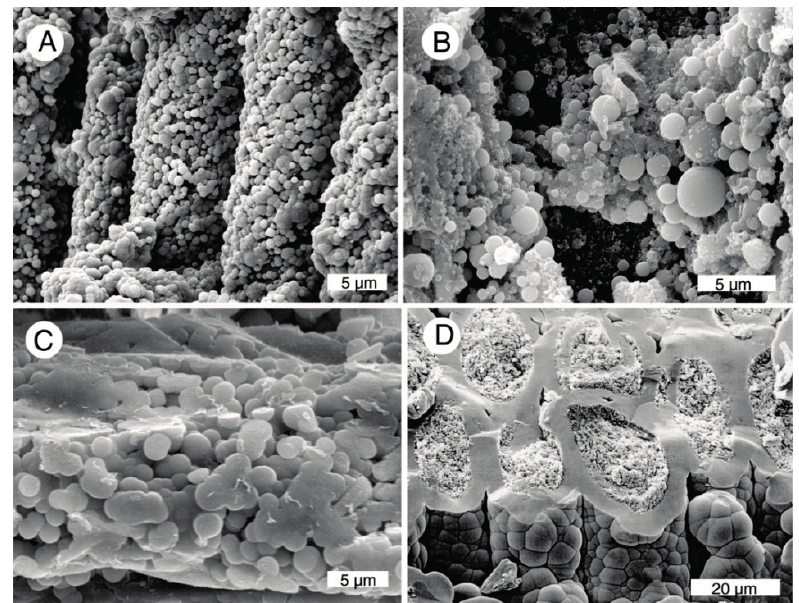
Figure 5. Examples of opal-A. ( A ) Tracheids coated with very small lepispheres, Location 2 (section 27 opal claim); ( B ) Lepispheres of varying diameters, Location 13; ( C ) Single tracheid mineralized with opal-A, location 14; ( D ) Oblique tangential view showing cell walls mineralized with botryoidal opal-A, lumina filled with porous opal-A, location 5.